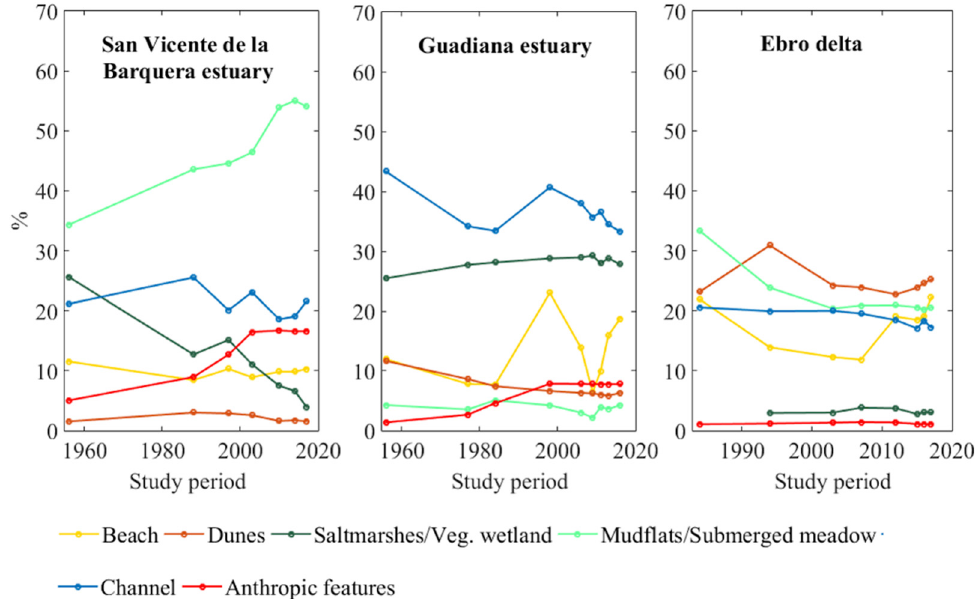
Figure 7. Temporal changes in the surface occupied by the main subsystems (Category 1) for the three study sites (% referred to the reference surface for each study site). Note the temporal scale changes on the x ‐ axis.